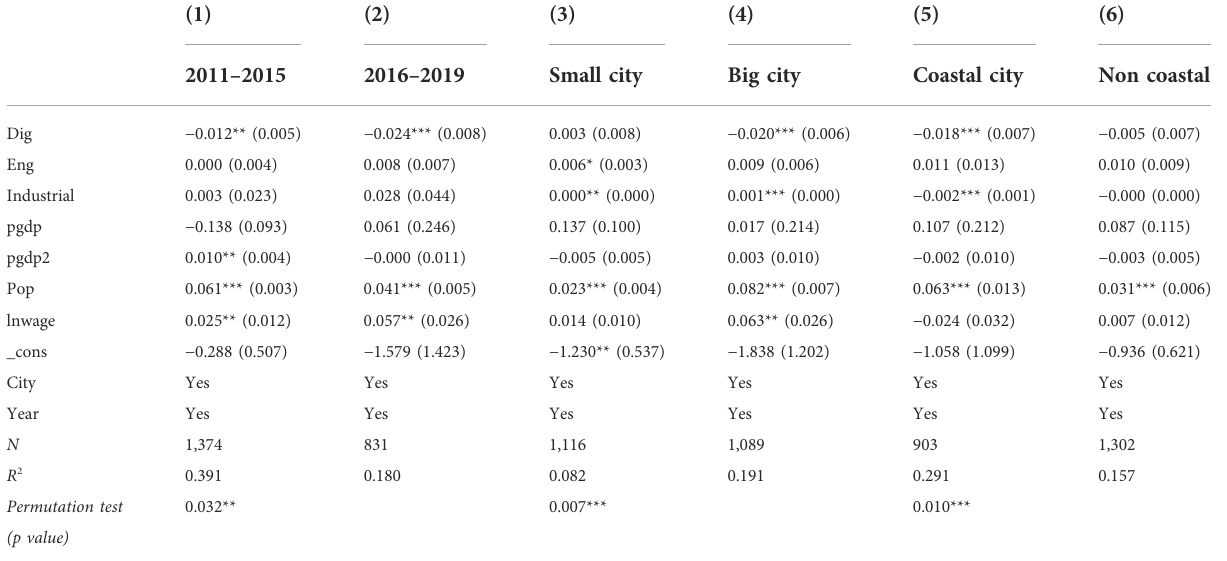
TABLE 6 Policy time, city size, and coastal heterogeneity